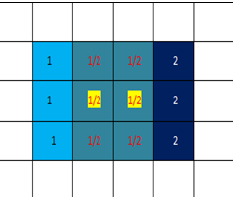
Figure 4. Diagram of overlapping with structural elements movement.